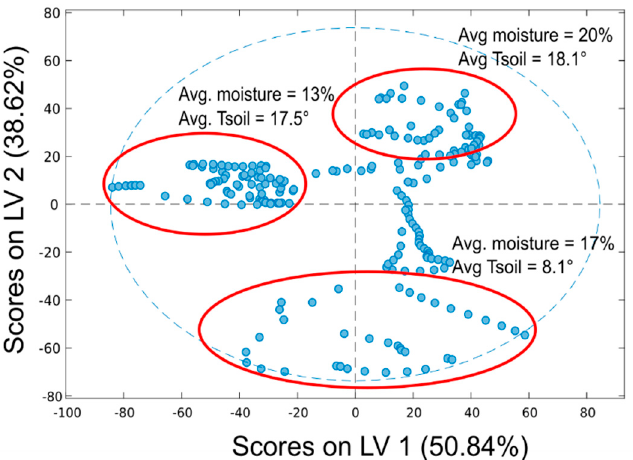
Figure 10. Scores plot for the PLS model in calibration obtained for “gain” spectra (first two latent variables (LVs)).